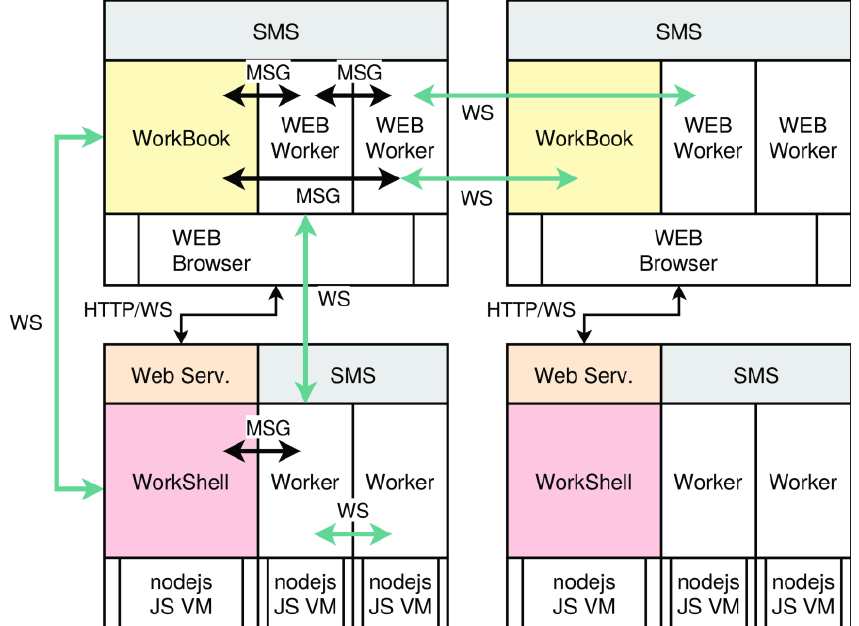
Figure 3. Different communication methods are used to connect the cluster nodes and their worker processes. The Web Service port is used for remote worker control.